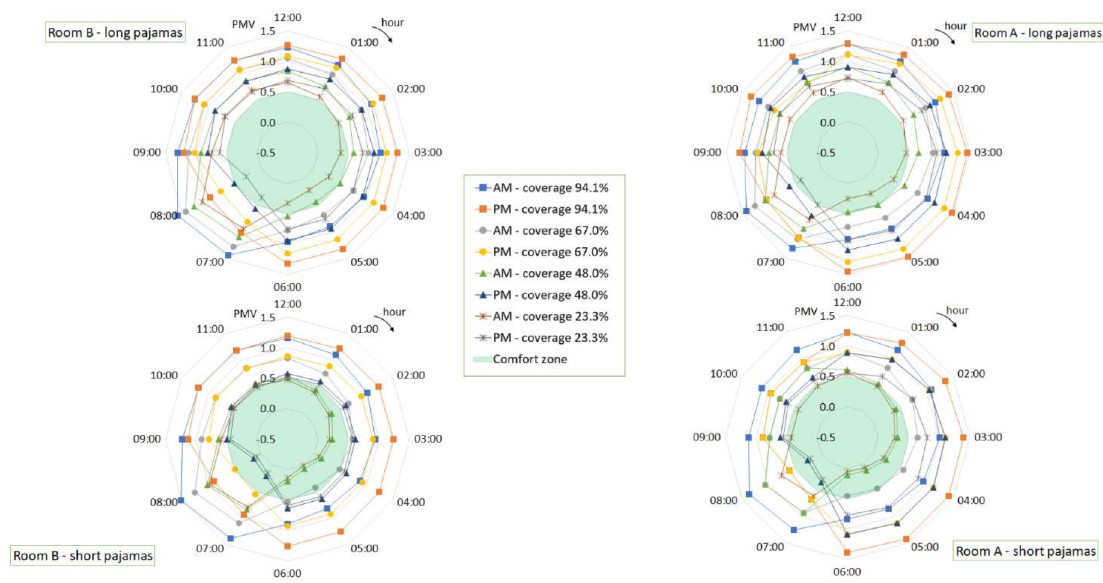
Figure 10. Hourly PMV of bedridden patient: different coverage rate and clothing in the summer